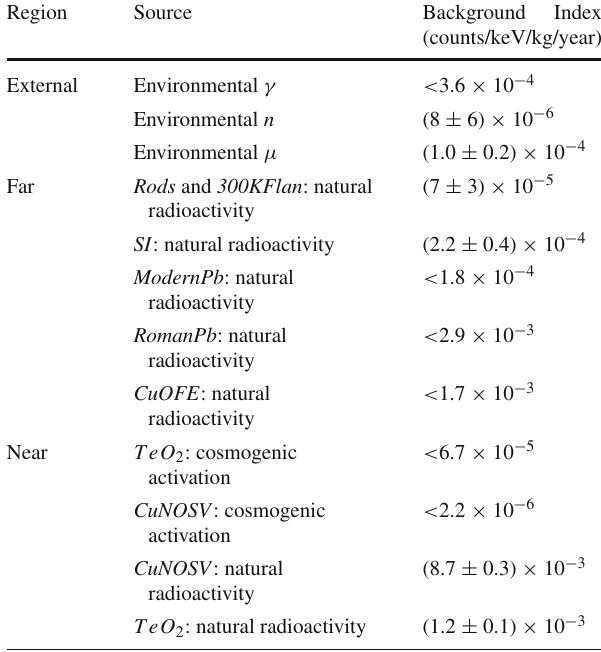
Table 8 Main background indexes expected for the various compo- nents of CUORE (limits are 90% C.L.) Region Source